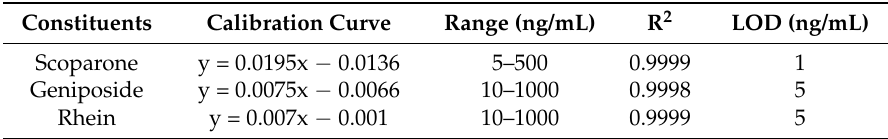
Table 2. Calibration curve of scoparone, geniposide and rhein.